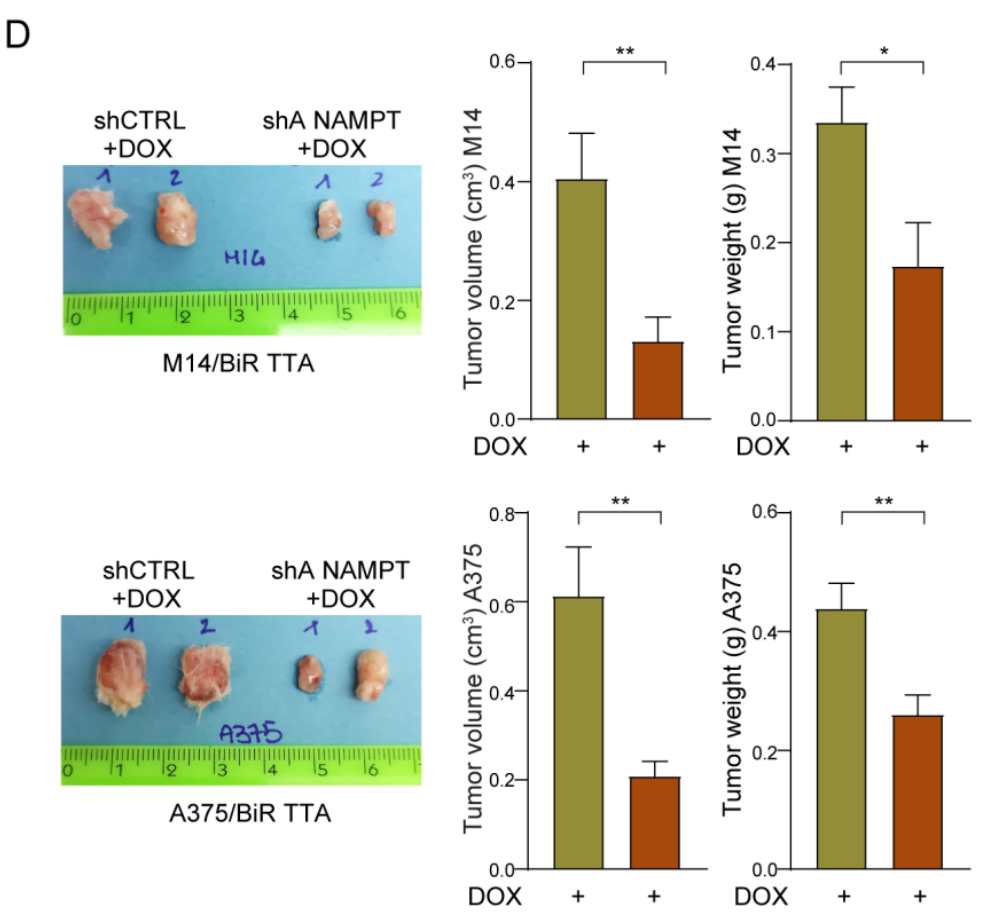
Figure 6. NAMPT silencing reduces tumor growth of / BiR cells in vitro and in vivo. ( A ) Representative NAMPT western blot ( B ) in M14 / BiR TTA and A375 / BiR TTA cell lines with a DOX-dependent inducible NAMPT silencing (using two di ff erent shRNAs NAMPT sequences A , C ) in comparison with shCTRL cells. Densitometry intensity ratios of NAMPT bands over actin were reported. ( B , C ) Colony-forming ability of shA NAMPT ( B ) or shC NAMPT ( C ) in comparison with shCTRL M14 / BiR TTA and A375 / BiR TTA cell lines treated with DOX (1 µ g / mL) every 72 h for 12 days. Cells were stained with crystal violet and representative images are shown. On the right, histograms show the cumulative quantification of the percentage (%) of the area with colonies at the end of the 12-days period (at least 5 independent experiments, Mann–Whitney test). ( D ) Representative tumor masses derived from NSG mice xenografted with M14 / BiR TTA and A375 / BiR TTA cell lines inducible shA NAMPT and shCTRL variants (5 × 10 6 cells, injected subcutaneously) and treated with DOX (0.1 mg / mL, twice a week orally) 24 h after injection for 4–5 weeks. At least 8–10 animals under each condition were evaluated. Graphs represent cumulative tumor volume and tumor weight measurements when mice were sacrificed, in both cell lines (Mann–Whitney test). Data in the Figure are presented as the mean ± SEM. Significance was represented as: * p ≤ 0.05, ** p ≤ 0.01, *** p ≤ 0.001 and **** p ≤ 0.0001. Uncropped Western Blot Images in Figure